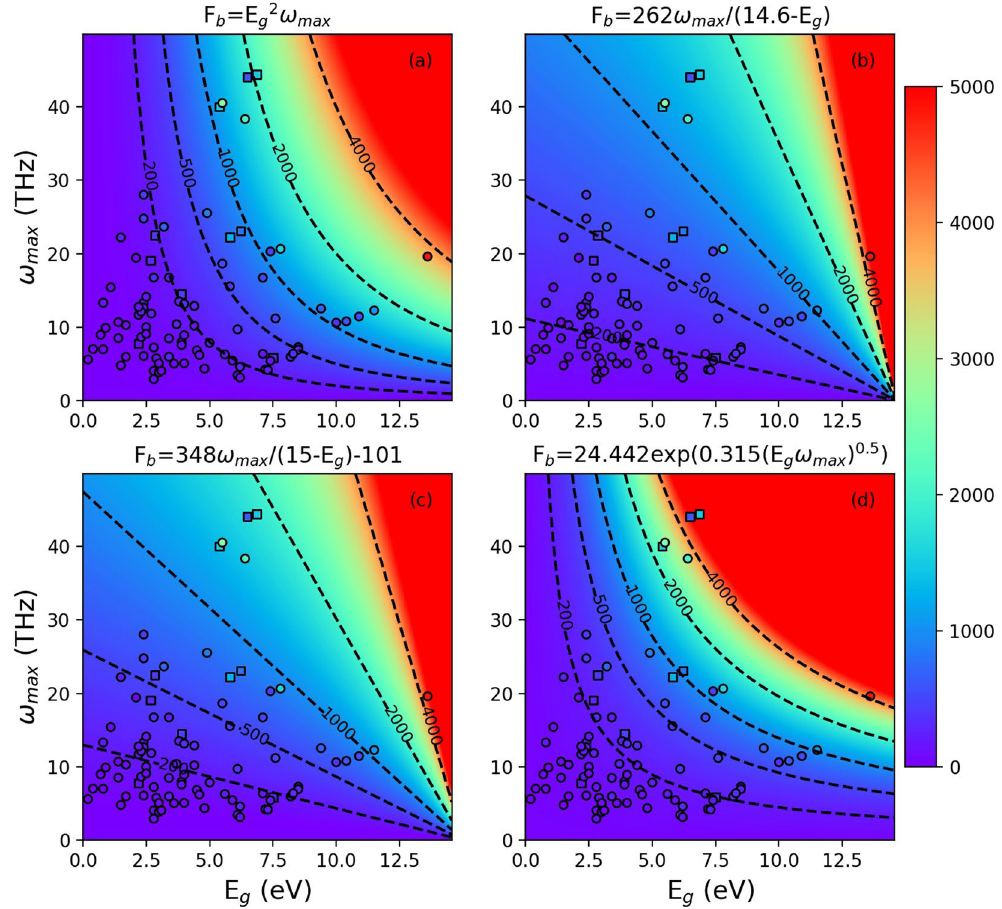
Figure 9. Contour plot of dielectric breakdown strength F b predicted by machine learning along with scatter plot of the values calculated by density functional theory (DFT) for ( a ) solution S1, ( b ) solution S2, ( c ) solution S3 and ( d ) solution S4 (the LASSO solution). The circles are training and validation data, and the squares are test data. The spheres and squares share the same color-coding scheme as the contour plot. The black dashed lines indicate contour levels labeling machine-learning-predicted F b values at 200, 500, 1000, 2000, 4000